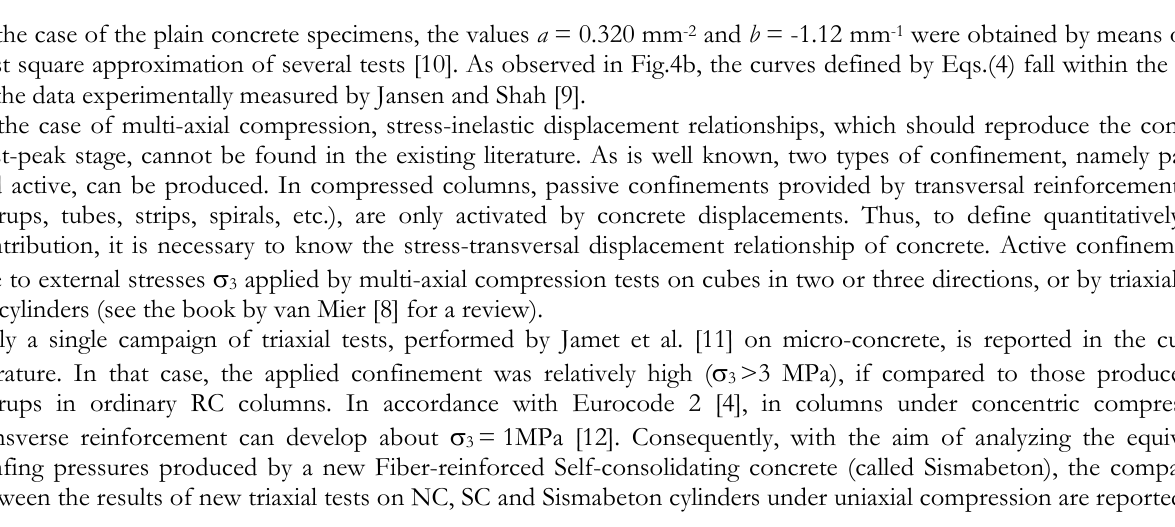
Figure 4: The stress-inelastic displacement relationship proposed by Fantilli et al.